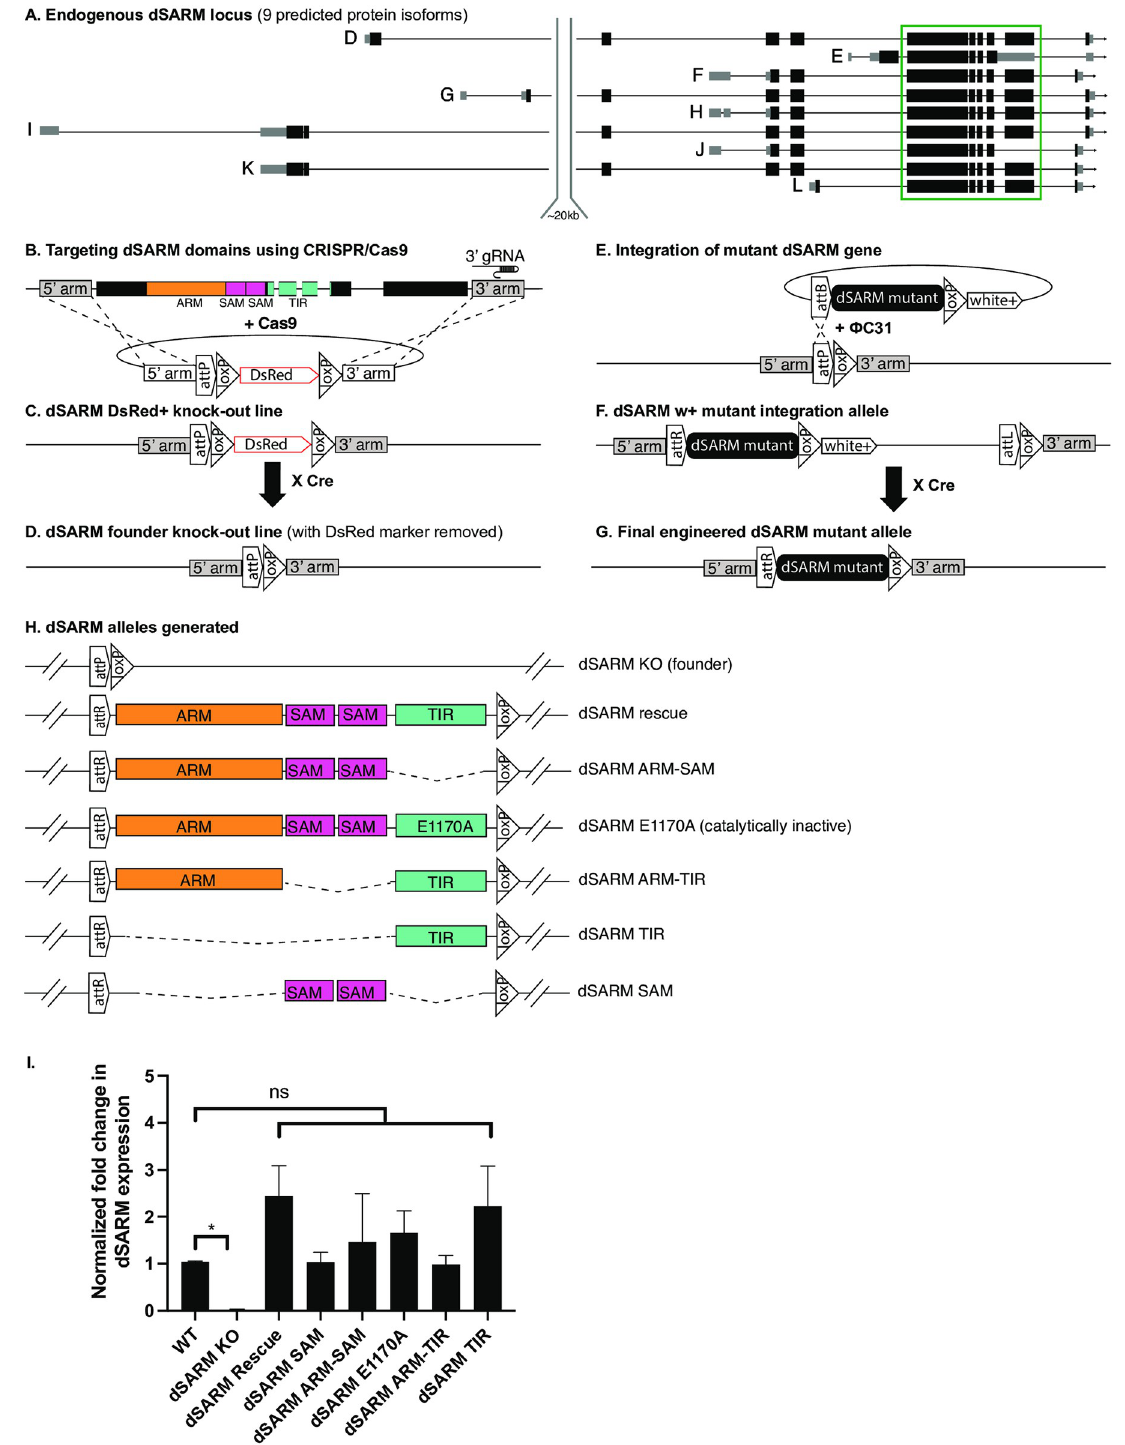
Fig 1. Genome engineering of the dSARM locus. (A) dSARM has 9 predicted isoforms. We designed a CRISPR/Cas9 strategy to knock out the ARM, SAM, and TIR domain encoding exons (boxed in green) in all isoforms. (B) A CRISPR/Cas9-induced homology-directed repair gene-targeting approach is used to delete the domain-encoding exons of dSARM . We identified a gRNA target sequence in the 3’ intron immediately following the exons in the green box in A. The homology-directed repair donor DNA plasmid contains 5’ and 3’ homologous arms flanking dSARM domains, a loxP-flanked DsRed selection marker, and an attP site of phiC31. The ARM (orange),